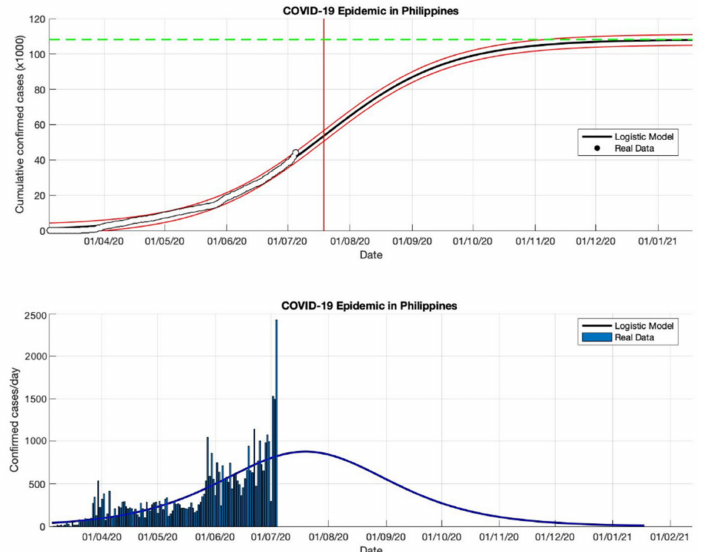
Figure 13. In the above figure, the prediction results of the logistic growth model for cumulative infected cases are compared with the actual data, while the two red lines between the black lines represent a prediction error limit of about 5%. The dashed green line predicts the total size of infected cases in the final phase of the epidemic. The red line intersects the cumulative case curve to predict the turning point or peak point of the epidemic (this line is parallel to the top of the curve from the below figure). In the below figure, the prediction results of this model for daily infected cases in